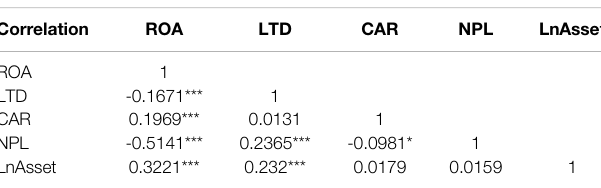
TABLE 5 | Correlation analysis